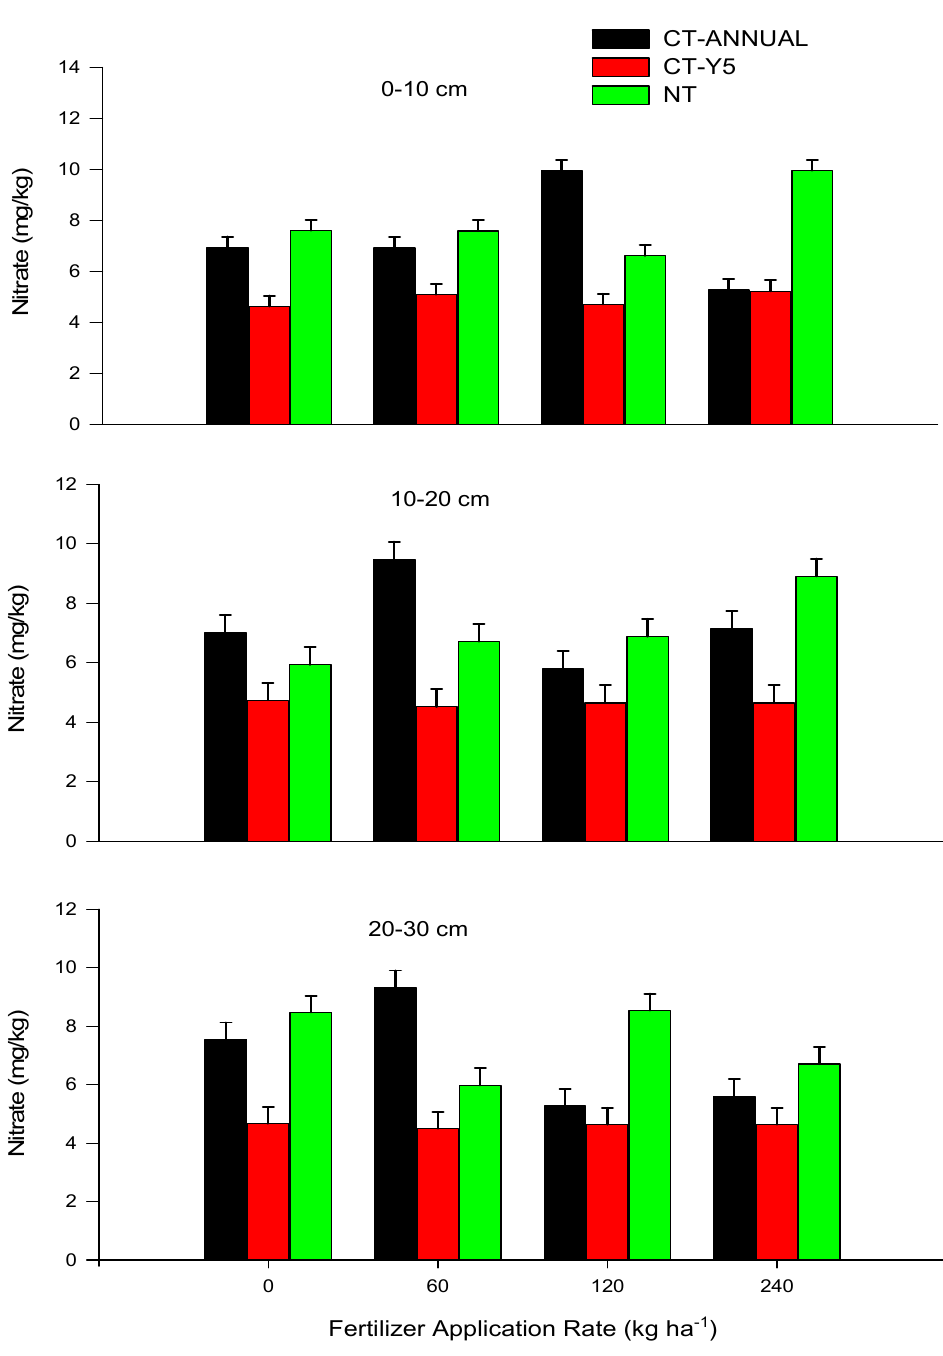
Figure 2. Contents of nitrate-N according to depth under different tillage techniques and urea fertilizer application rates.